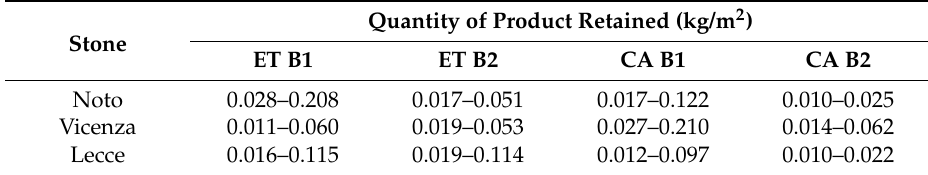
Table 1. Range of the amount of product retained after one month from the application.